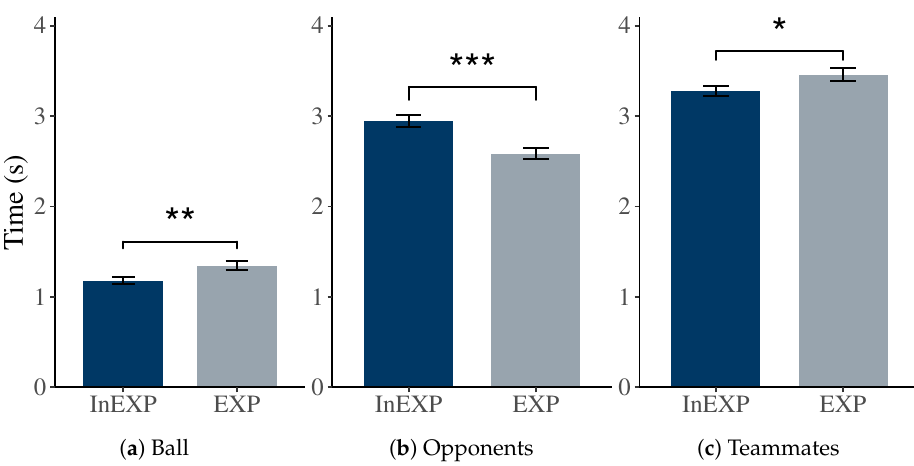
Figure 5. The bar charts depict the mean and standard error of the amounts of time during which inexperienced (InEXP) and experienced (EXP) soccer players focused on the ball ( a ), opponents ( b ) and teammates ( c ). * p < .05; ** p < .01; *** p <